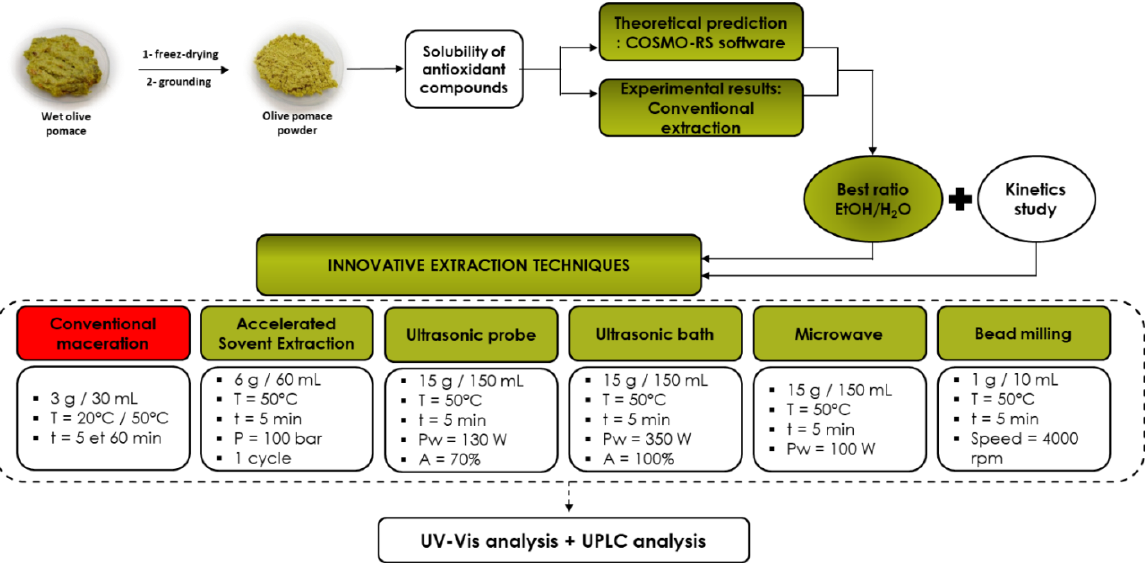
Figure 1. Global protocol for olive pomace extraction.